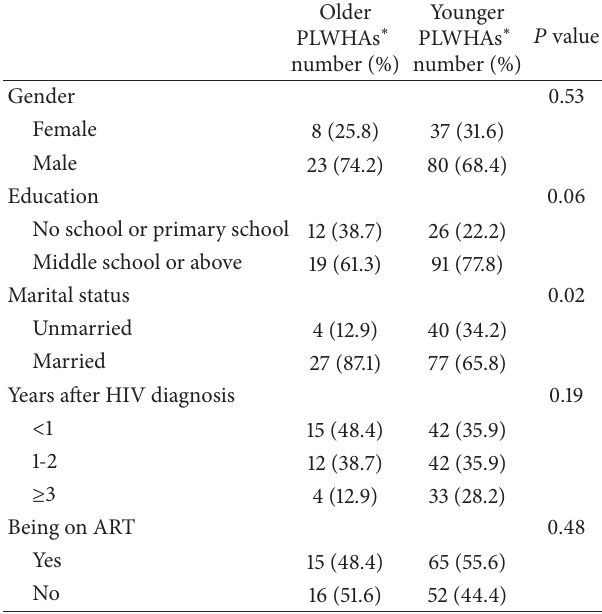
Table 1: Demographic characteristics of two